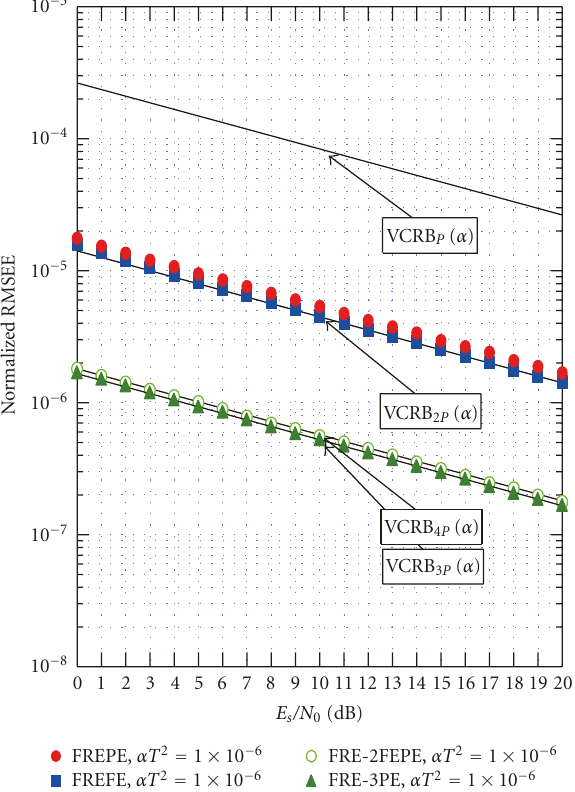
Figure 9: RMSEE of FREPE, FREFE, FRE-3PE, and FRE-2FREPE estimators for di ff erent values of E S /N 0 and relevant bounds,—solid lines: theory—marks: simulation. Doppler-rate algorithms: FREFE versus FREPE versus FRE-3PE versus FRE-2FEPE, N = 44(45), M = 385(384), vT = 1 . 0 × 10 − 3